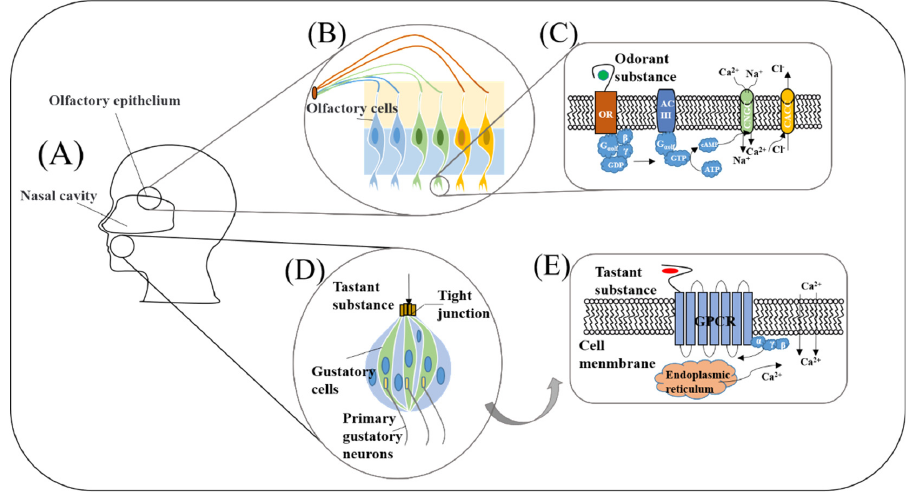
Figure 2. The overall structure of human olfactory ( A – C ) and gustatory systems ( A , D , E